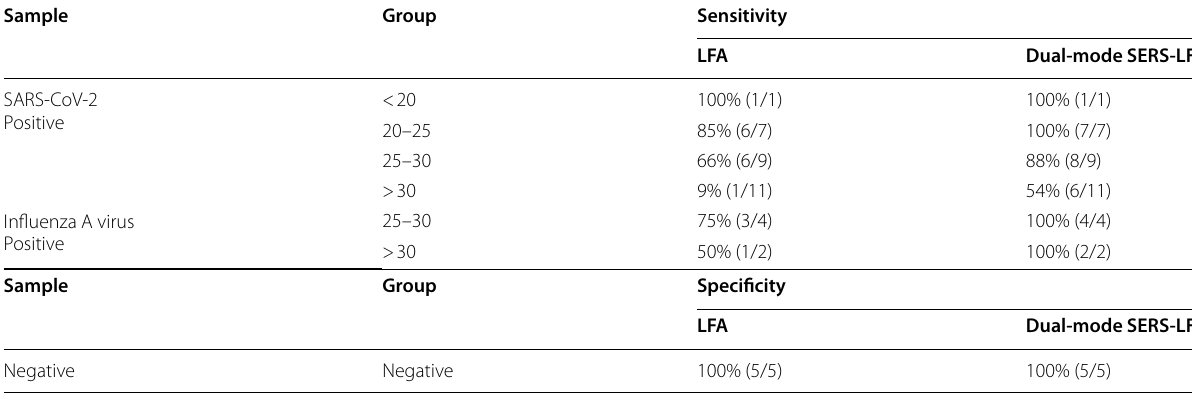
Table 2 Statistical analysis of the diagnostic results of SARS-CoV-2 and influenza A virus using LFA and dual-mode SERS-LFA strips on 39 clinical